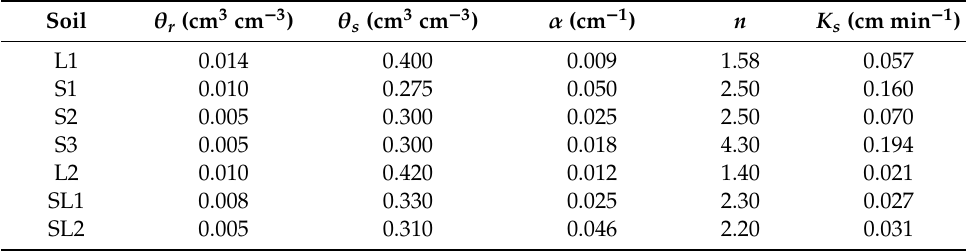
Table 2. The van Genuchten-Mualem (VGM) parameters used in the Richards equation-based model